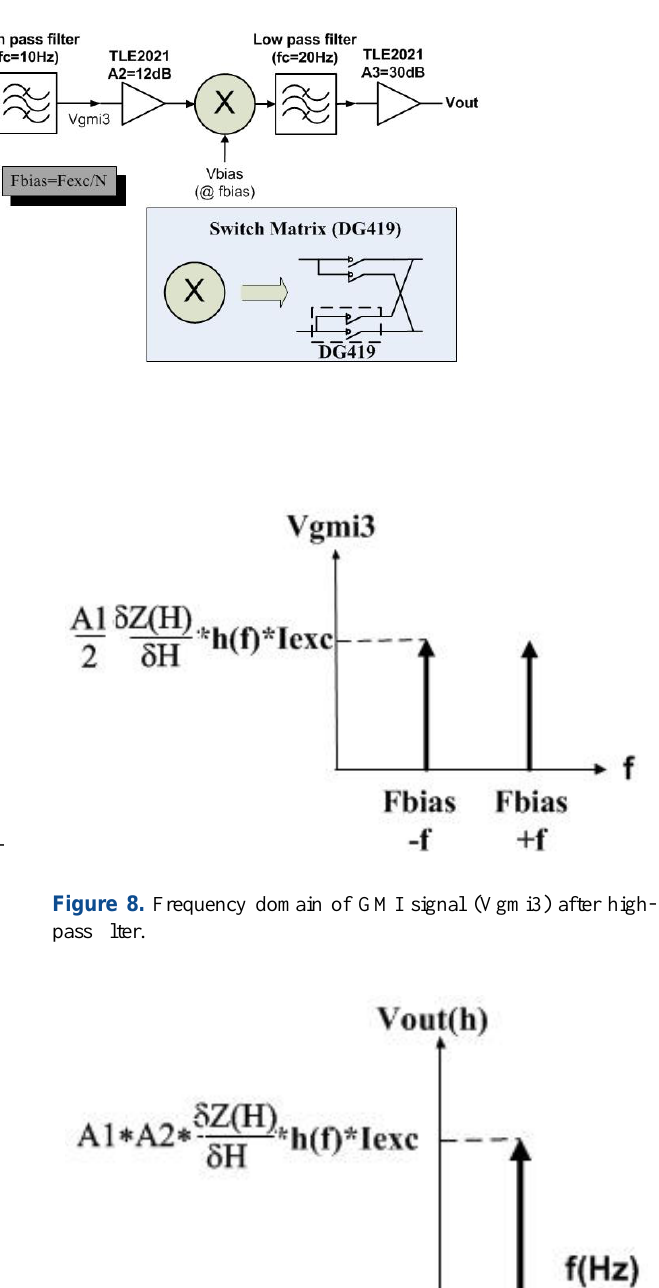
Figure 9. Frequency domain of GMI signal (Vgmi4) after multi- plication by clock at f bias , amplification ( A 2) and low-pass filtering.